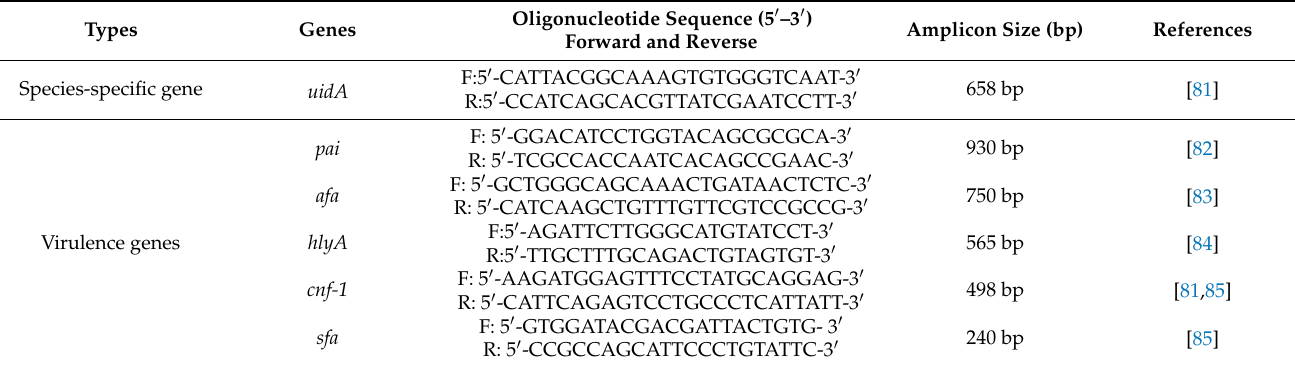
Table 2. Primer names and sequences for different gene markers in this